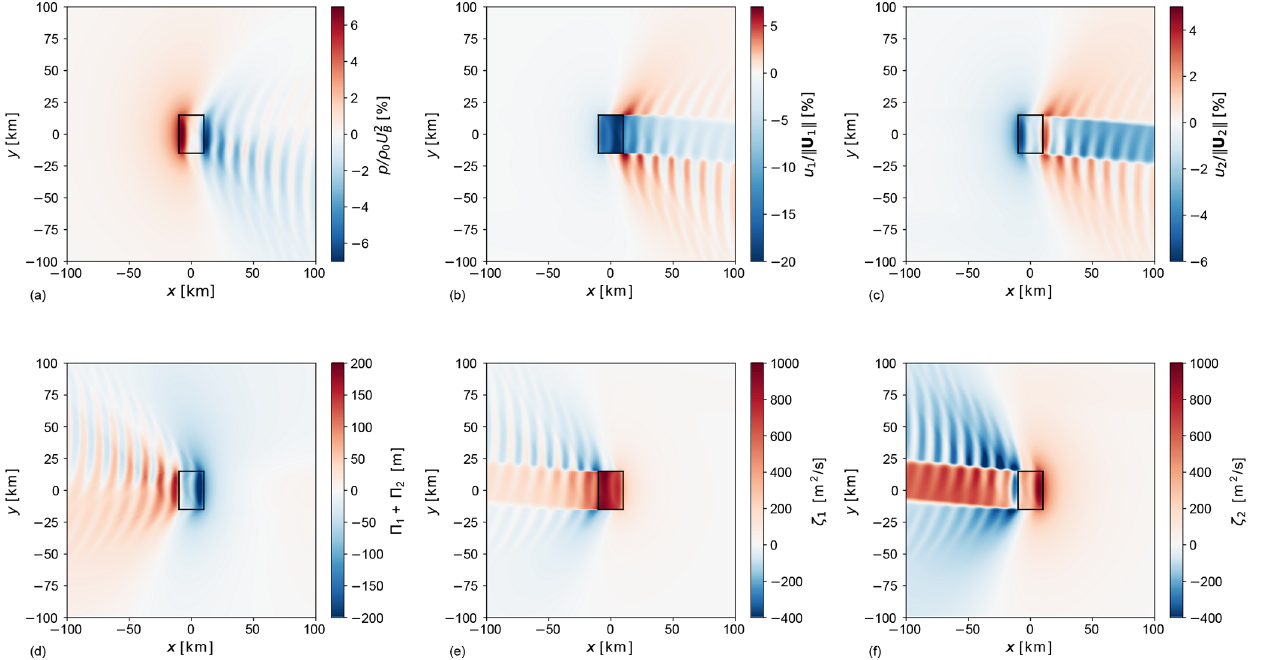
Figure A1. Planform view of (a) pressure perturbation, (b) velocity perturbation in the wind-farm layer, (c) velocity perturbation in the upper layer, (d) adjoint pressure (cid:53) = (cid:53) 1 + (cid:53) 2 , (e) adjoint velocity field in the wind-farm layer and (f) adjoint velocity field in the upper layer in subcritical ( Fr = 0 . 9) flow conditions. The black rectangle indicates the wind-farm region.